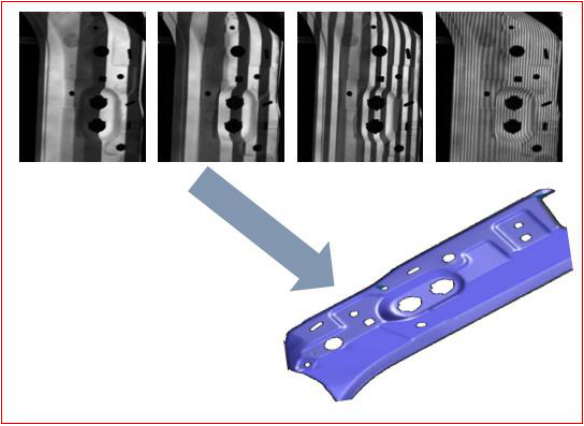
Figure 4: Fringe projection